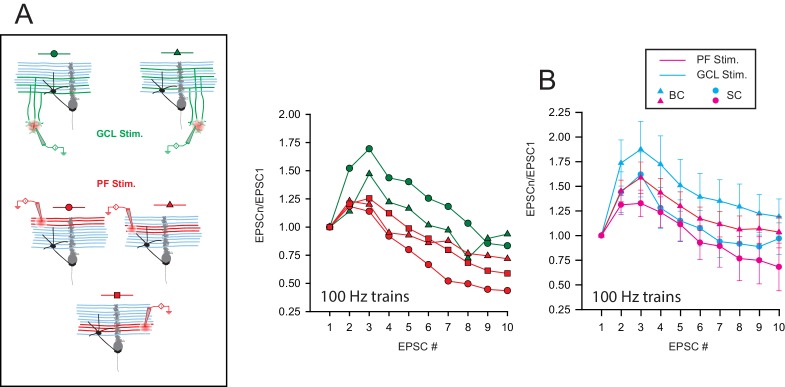
STP profile at compound GC-MLI synapses is not determined by the target cell upon.(A) Right, schematic of the experimental design used to probe STP profiles on a single MLI following compound stimulations of GC-MLI synapses. In this example, synaptic responses in a BC were recorded upon stimulations (10 pulses at 100 Hz) of three different clusters of GCs (stimulation in GCL, green symbols) and two different beams of PFs (red symbols). Left, Corresponding compound EPSC responses recorded in the BC following stimulations of the five different locations showed on the schematic. Depending of the location of the stimulation pipette, compound EPSC responses either facilitated or depressed. (B) Mean EPSC responses recorded in BC (triangles) or in SC (circles) following compound stimulations of beams of PFs (pink triangle for BCs, n = 9 and pink circles for SCs, n = 6) or clusters of GC soma (blue triangles for BCs, n = 11 and blue circles for SCs, n = 9).